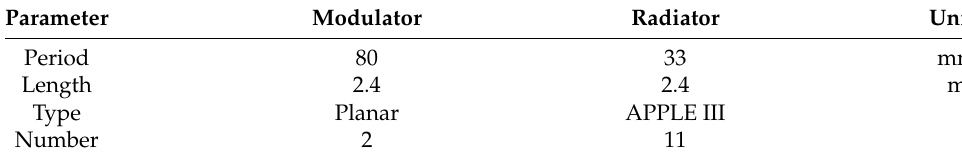
Table 4. Seeding undulator parameters.